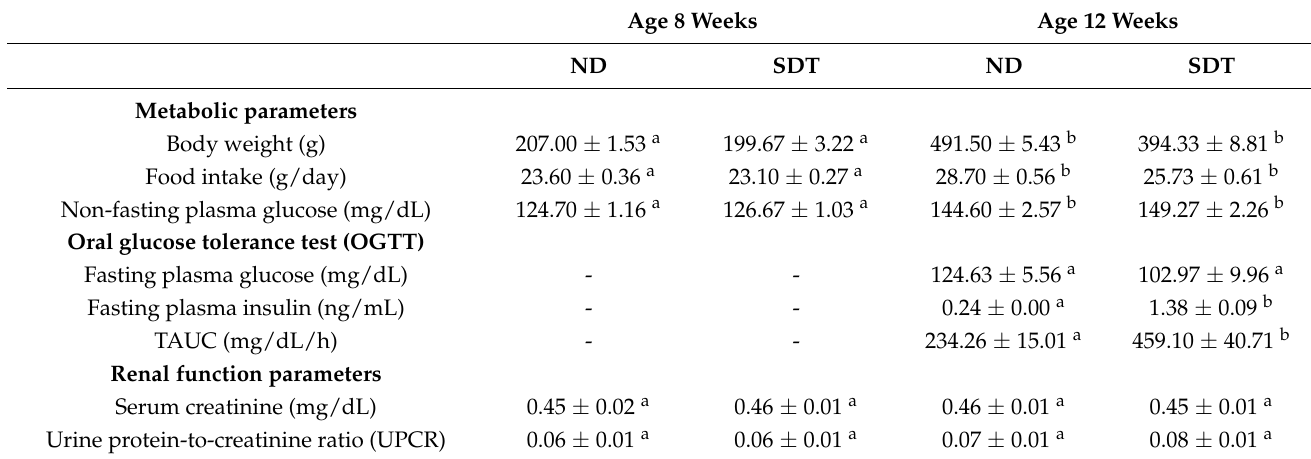
Table 2. Metabolic and renal function parameters in all experimental groups at the age of 8 and 12